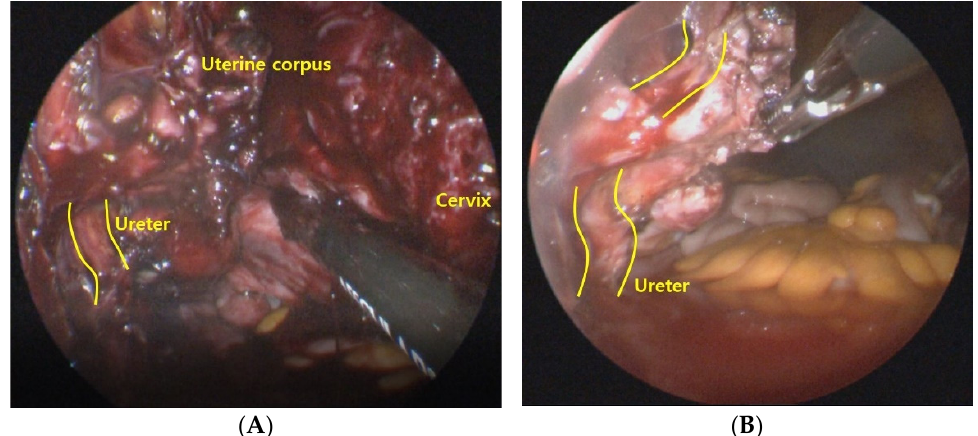
Figure 2. Sagittal image of urography CT (computed tomography) showing left distal ureteral con- trast leakage with profuse amount of fluid collection in the abdominal cavity.